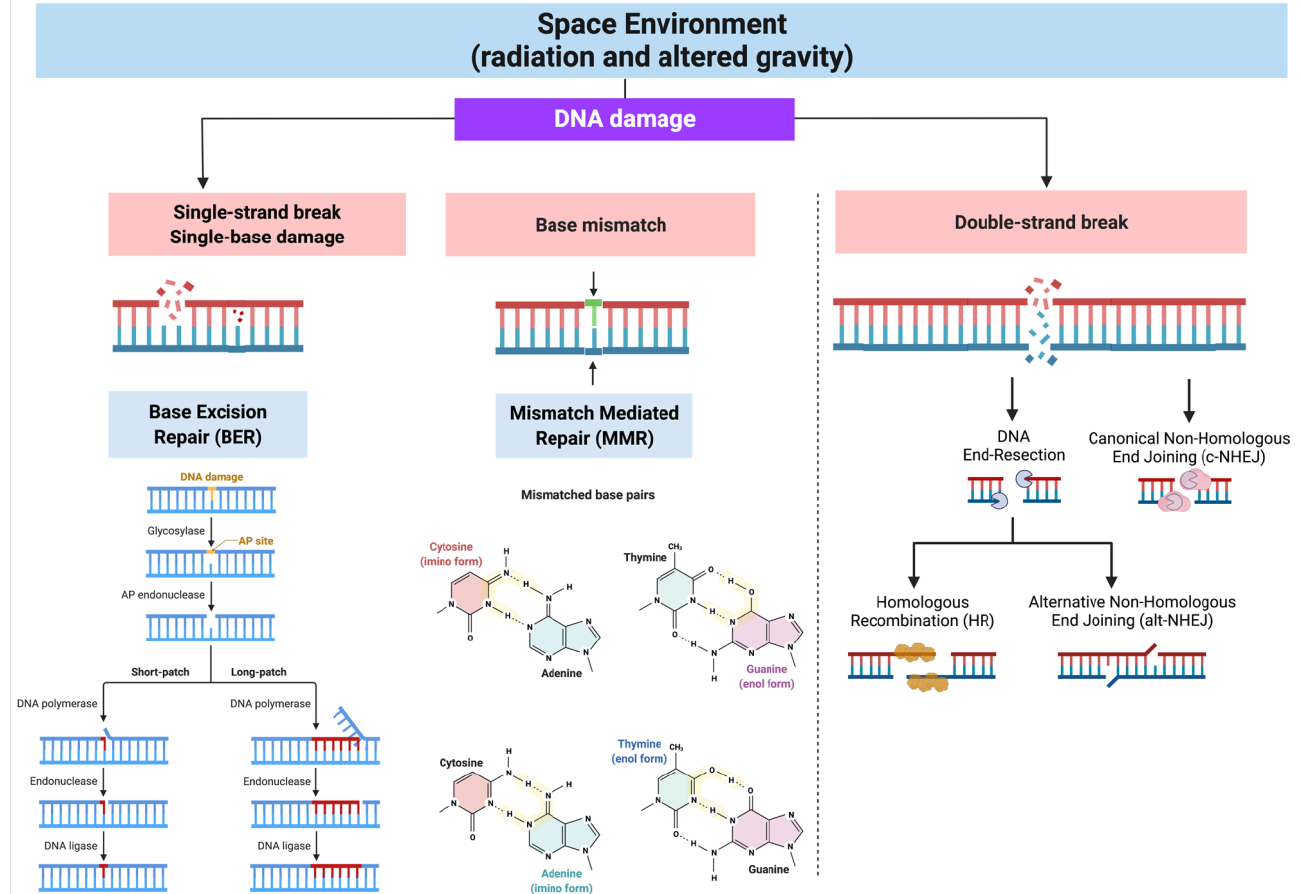
Figure 2. DNA repair pathways associated with DNA damage originated in space environment. The different types of DNA damage induced by ionizing radiation and altered gravity are repaired by components of Base Excision Repair (BER), Mismatch Mediated Repair (MMR), Homologous Recombination (HR) and Non-Homologous End Joining (NHEJ, canonical and alternative) pathways. Oxidative DNA damage in the form of oxidized bases, oxidized pyrimidine derivatives, oxidized base-derived apurinic/apyrimidinic sites are repaired by BER and MMR systems. SSBs and DSBs, originated directly by radiation or indirectly by oxidative DNA damage, are repaired by BER and HR/NHEJ pathways, respectively. “Created with BioRender.com”.